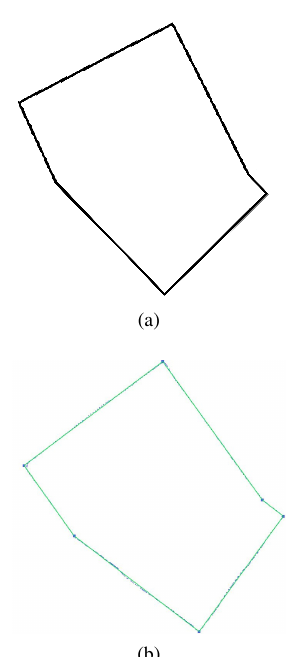
Figure 14: Final result for the concave room: (a) reference planimetry, (b) extracted